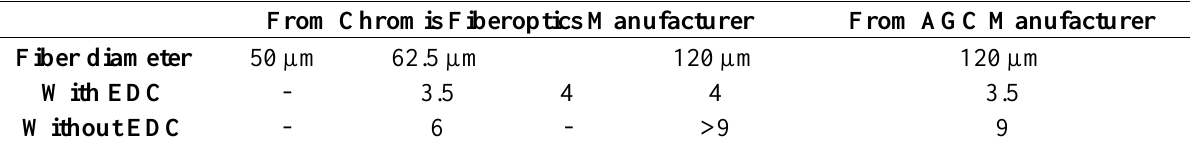
Table 3. Measurement of the power dispersion penalties (dB) of the optical link.